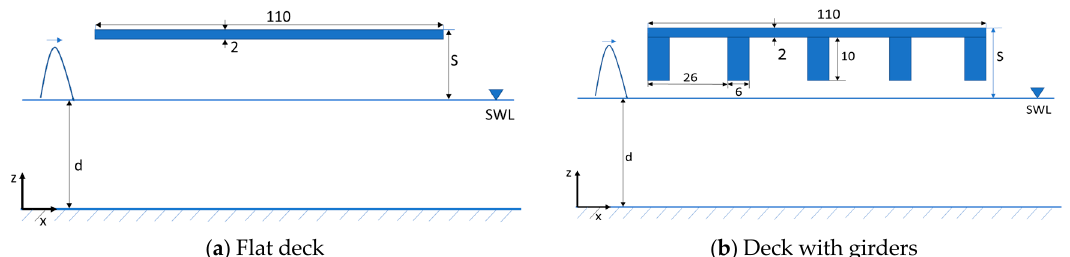
Figure 5. Flat deck and deck with girders arrangement in the numerical wave tank (Dimensions in cm).